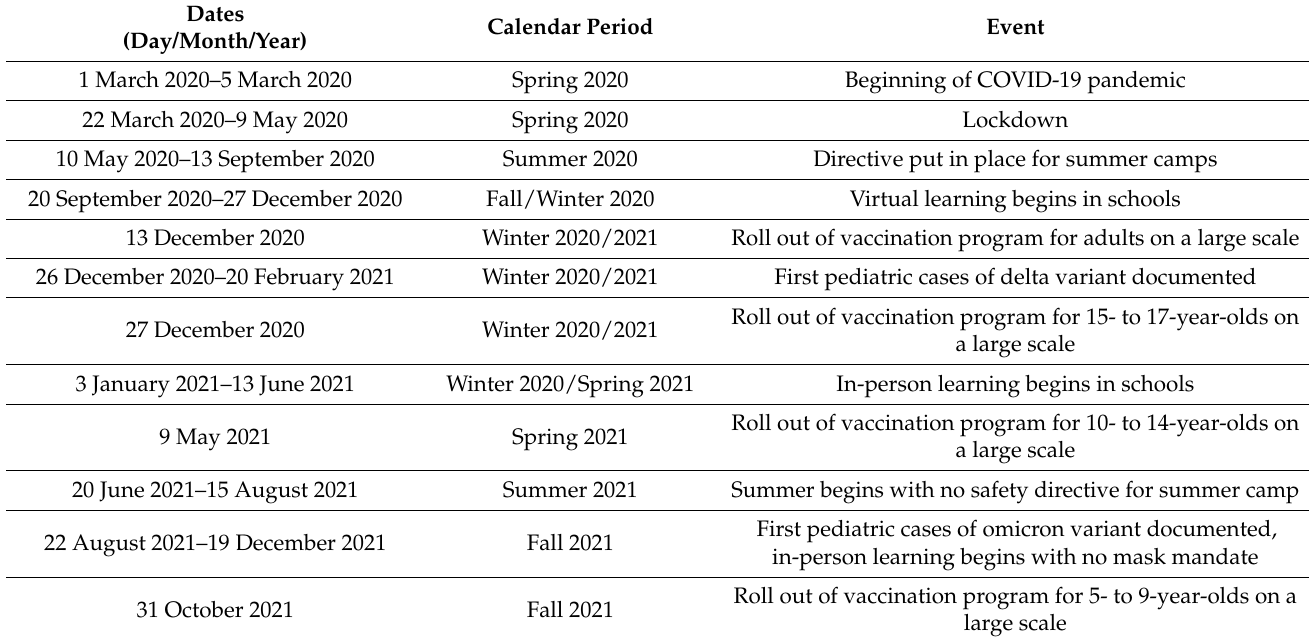
Table 1. Divisions and dates within the study period, allocated to weeks of